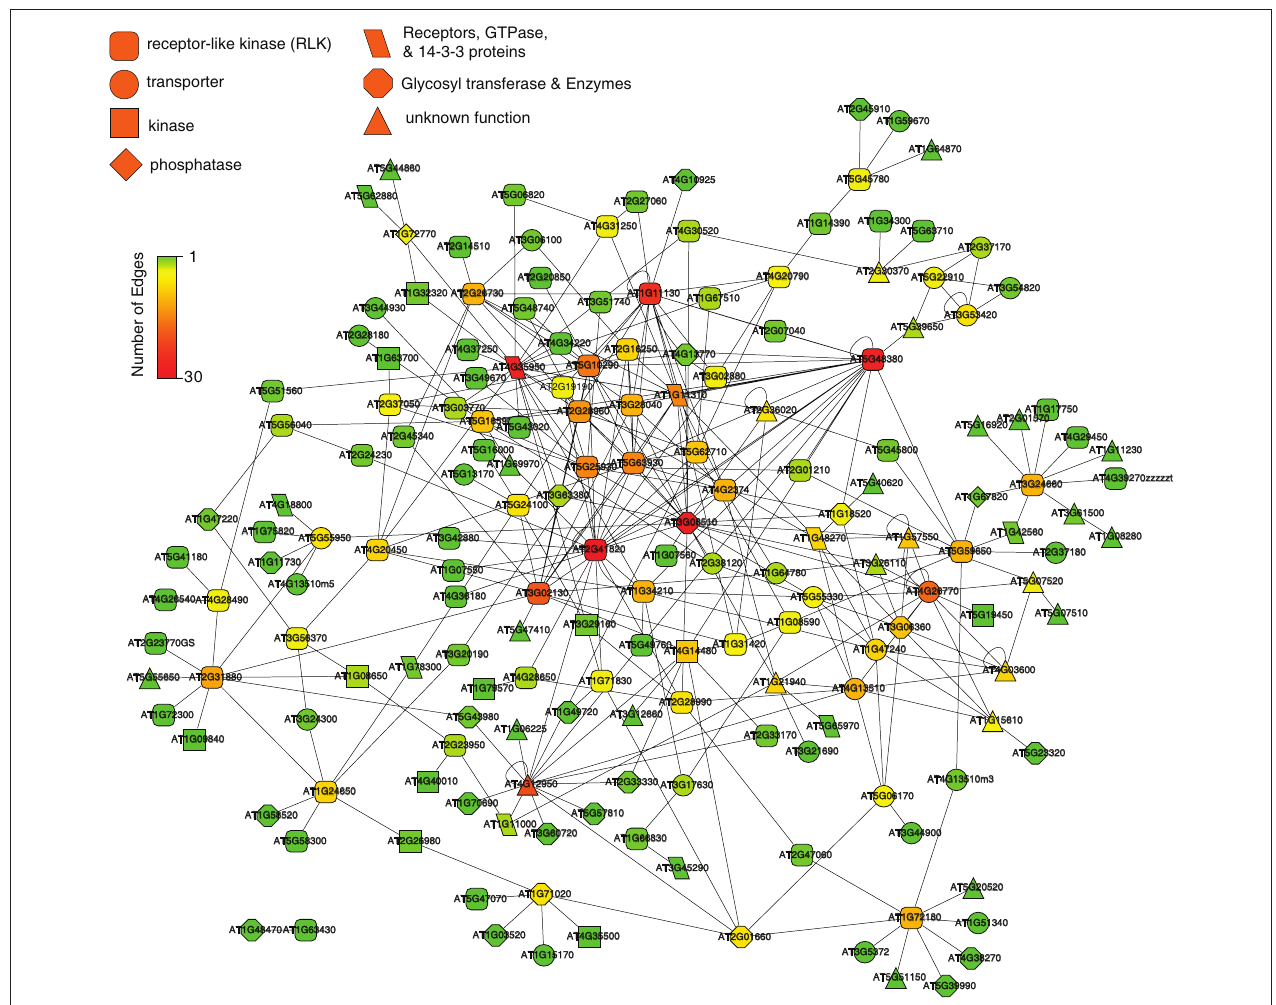
Figure 3 | AMPv2 pPPi network. Network of all pairs with a positive read-out for all three markers as visualized in Cytoscape. The network comprises 179 nodes and 343 edges. Symbol color corresponds to degree of interactions (color code on the left). Symbol shape indicates protein function (code at the